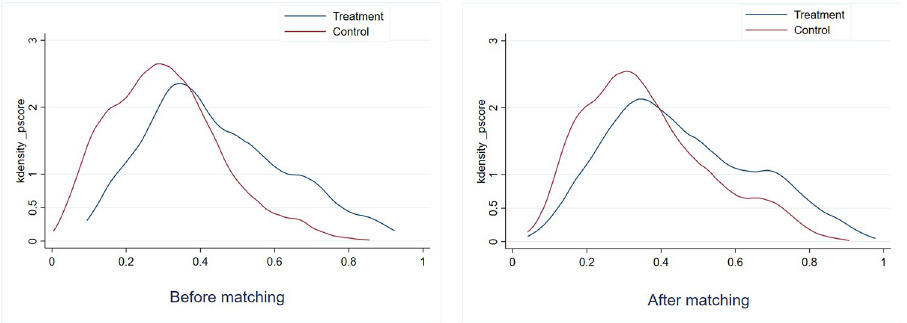
Fig 2. Comparison of kernel density distributions of